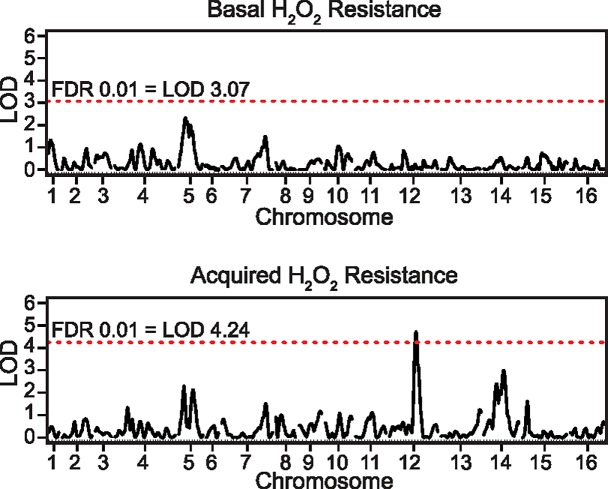
The genetic basis of natural variation for basal and acquired stress resistance is distinct.Linkage mapping of the S288c x YPS163 cross identified no significant QTLs for basal H2O2 resistance (top panel), but did identify a major QTL on chromosome XII for ethanol-induced cross protection against H2O2 (bottom panel). The red horizontal line denotes the LOD threshold for significance (1% FDR).